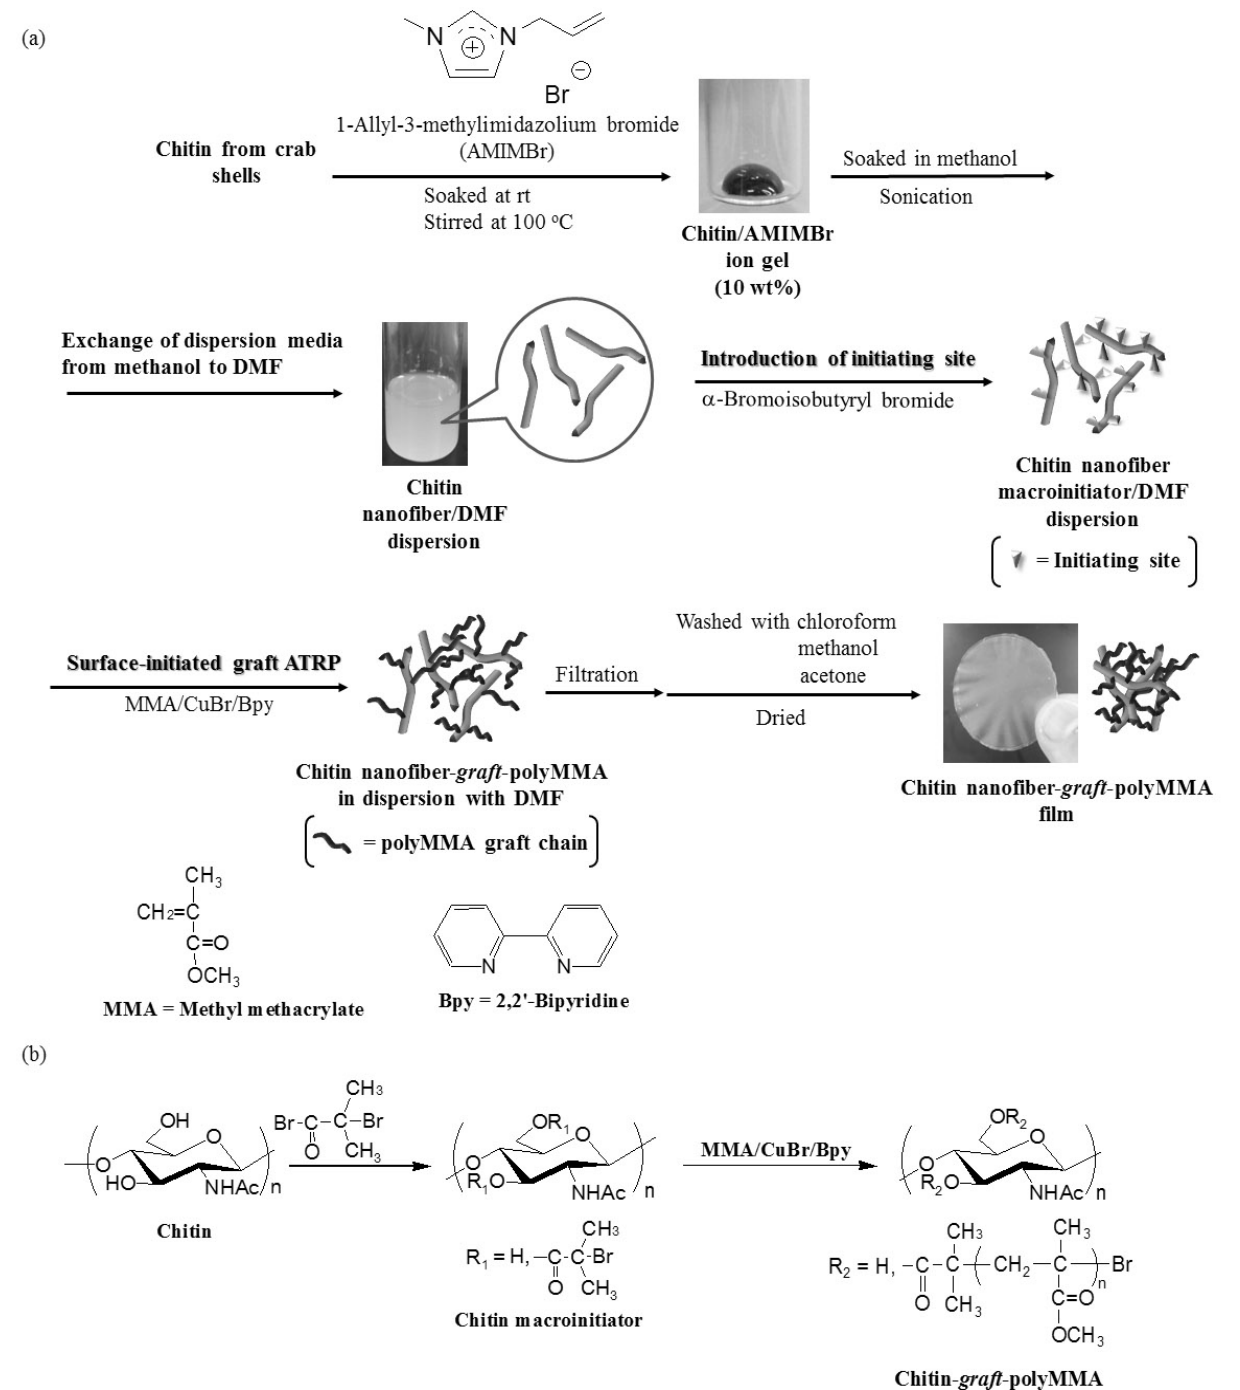
Figure 1. ( a ) Procedure for preparation of chitin nanofiber (CNF) macroinitiator in dispersion with DMF and surface-initiated graft ATRP of MMA under dispersion conditions; and ( b ) reaction scheme for chitin macroinitiator and chitin- graft -polyMMA (CNF- g